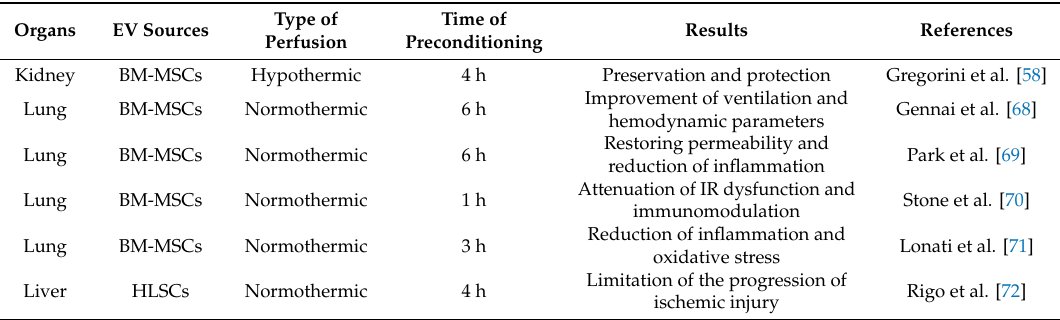
Table 1. List of EV applications for organ preconditioning. Abbreviations: bone marrow (BM), human liver stem cells